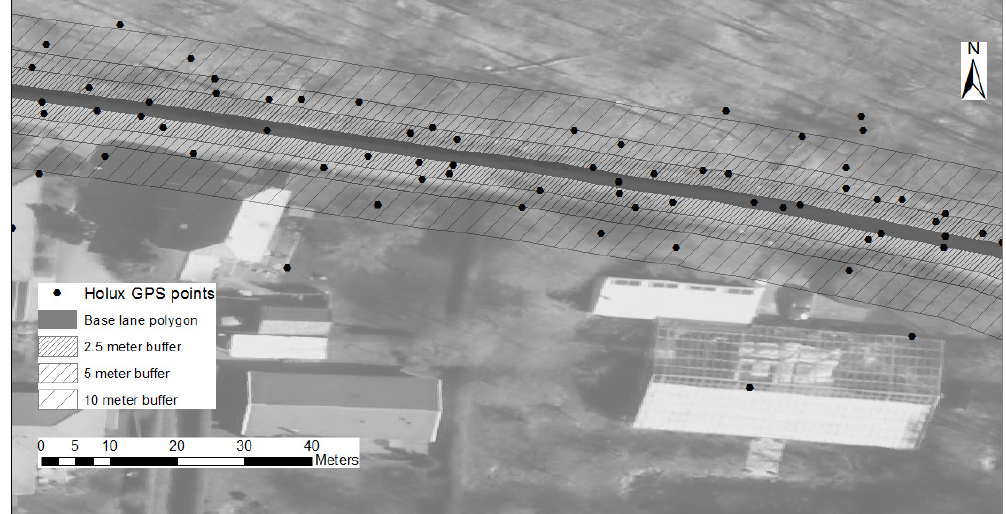
Figure 2. Buffers and Holux GPS points projected on the aerial photo of Odense